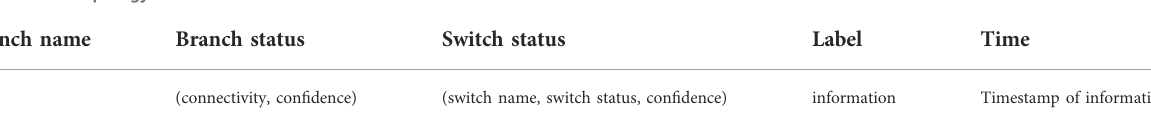
TABLE 4 The topology information table in STU.